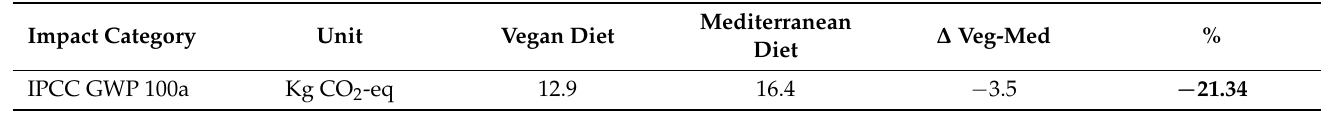
Table A3. Comparison of the two diets’ impact according to IPCC 2013. Impact Category